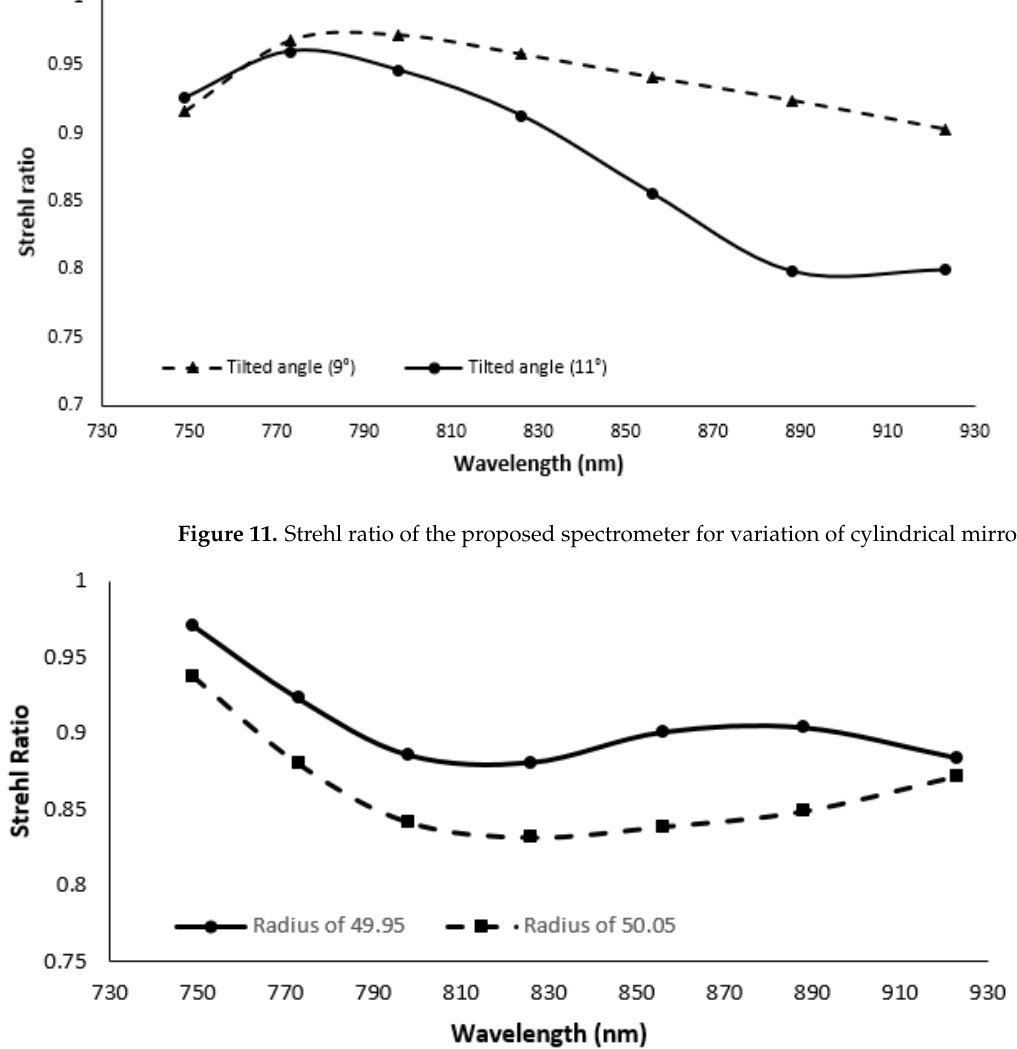
Figure 12. Strehl ratio of the proposed spectrometer for variation of cylindrical mirror’s